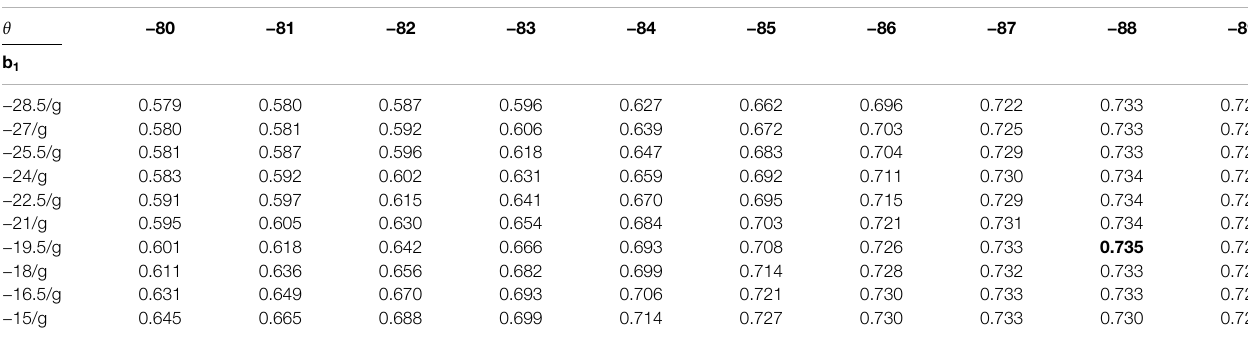
TABLE 3 | Variables and F-value (the bold value is maximum).